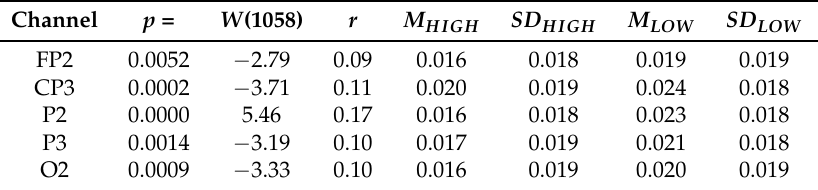
Table 5. Eyes-Closed (EC) setting. Channel-wise paired Wilcoxon rank sum tests for five channels (FP2, CP3, P2, P3, and O2) in which significantly higher distributed TEs were associated with LOW stress-susceptible group. p , W , and r refer to p -value, test-statistics, and the effect size for Wilcoxon rank sum tests. M and SD are the mean and standard deviation of these channels’ distributed TE values for HIGH and LOW stress-susceptible groups. The subscripts to M and SD mark the two groups. p